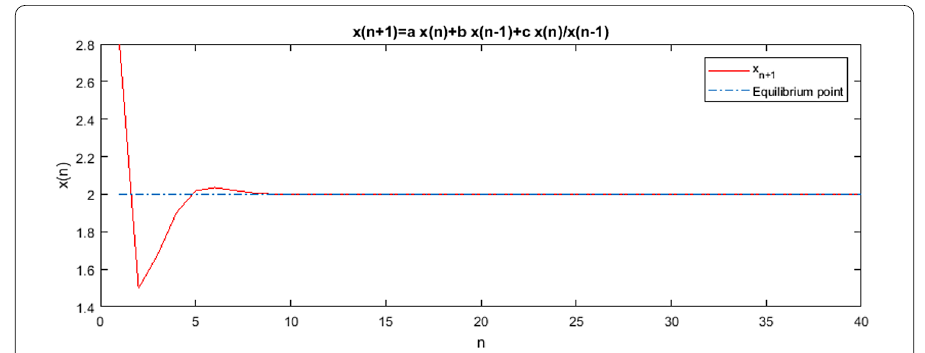
Figure 1 Stable solution corresponding to difference equation